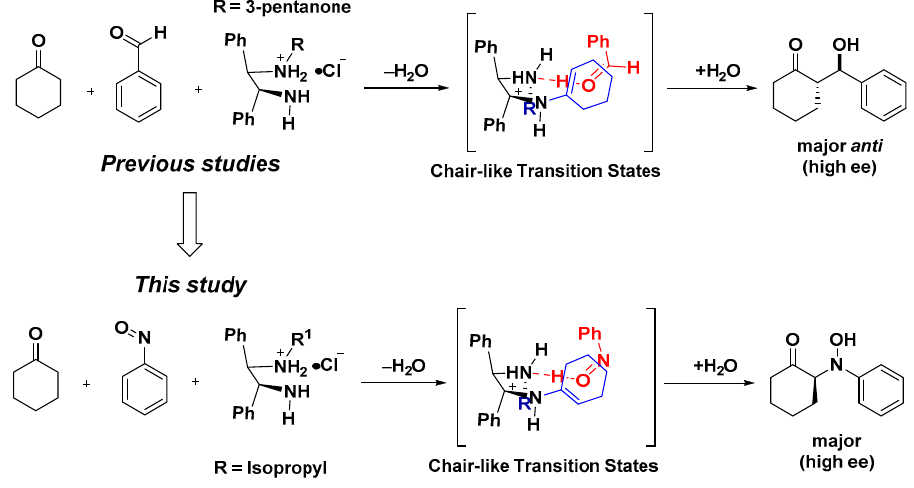
Figure 1. The nitroso aldol reaction via nitrosobenzene and cyclohexanone.